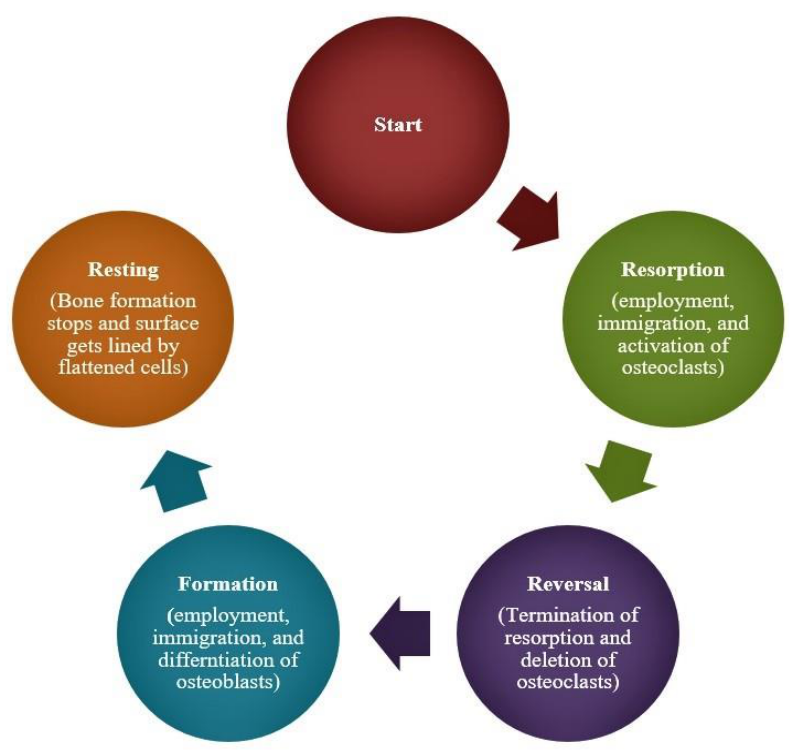
Figure 2. Flow chart depicting sequence of events during bony remodelling process. Adapted from Raggat and Partridge [29].